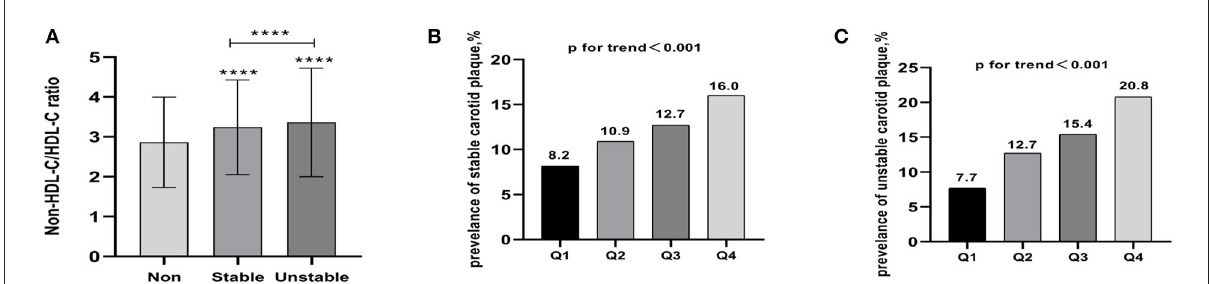
FIGURE1 (A) The mean non-HDL-C /HDL-C ratios of non-carotid plaque, stable carotid plaque, and unstable carotid plaque (mean ± SD ) increased gradually and this trend was statistically significant. (B) Prevalence of stable carotid plaque stratified by quartile the non-HDL-C/HDL-C ratio. (C) Prevalence of unstable carotid plaque stratified by quartile the non-HDL-C/HDL-C ratio. **** p <